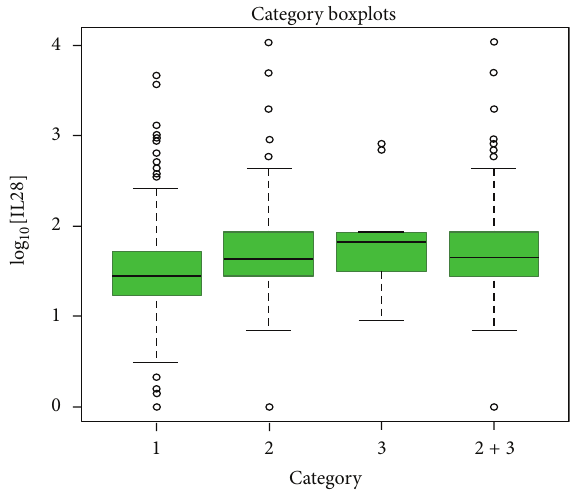
Figure 2: Boxplot analysis of average serum IL28B concentration with different outcomes of HCV